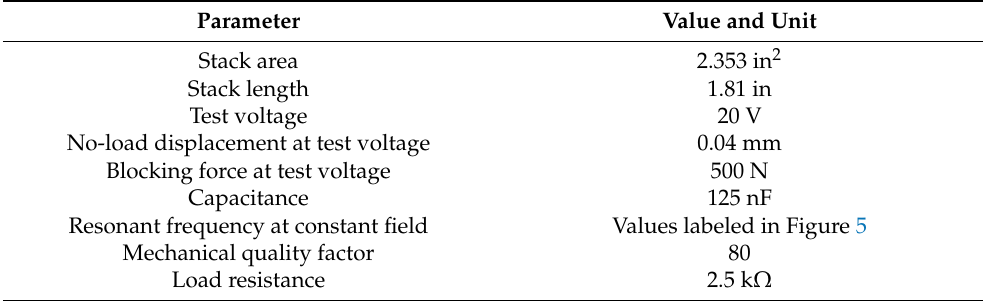
Table 1. Values of the model parameters for estimating the harvestable